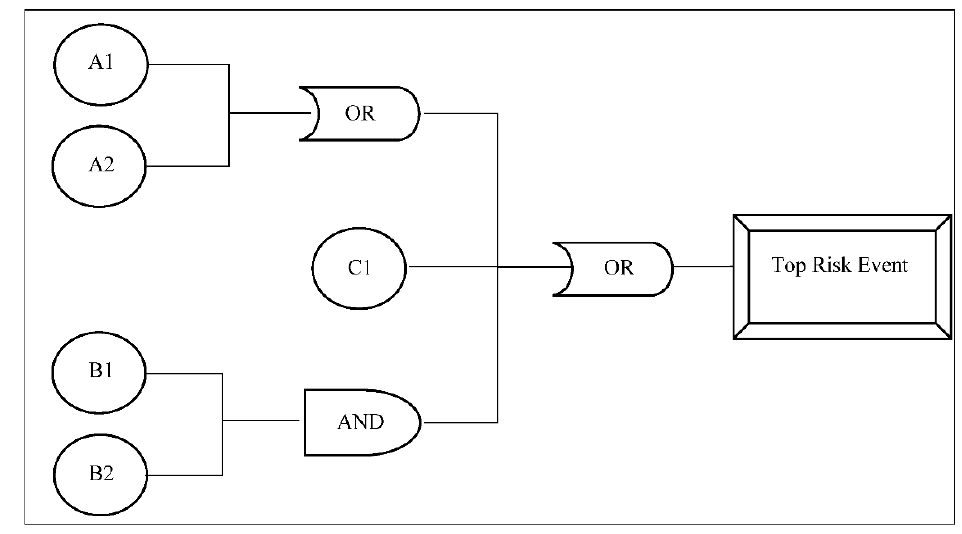
Figure 2. General fault tree.